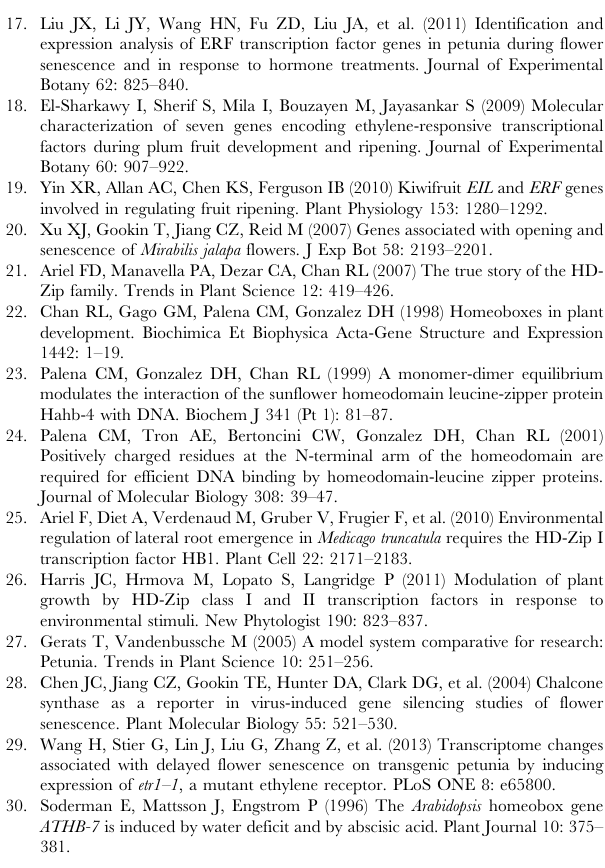
Figure S4 Silencing efficiency of VIGS determined by semi-quantitative PCR. Abundance of PhHD-Zip were deter- mined at D6 in purple control flowers (WT), in white flowers of plants inoculated with the CHS /TRV reporter construct (VW), and in purple flowers (PhHD-Zip(P)) and white flowers (PhHD- Zip(W)) of plants inoculated with the PhHD-Zip/CHS/TRV construct. A. A representative gel image from semi-quantitative PCR of RNA isolated from corollas. 26S RNA: the internal control. Samples were analyzed after 30 cycles PhHD-Zip and after 24 cycles for 26S RNA . B. Relative expression level of PhHD-Zip as determined by quantification of the gel pictures; error bars show SE of the means of three biological replicates; asterisks denote significant differences using Duncan’s test at P , 0.05). Figure S5 Phenotype of plants over-expressing PhHD- Zip . Representative fully-expanded young leaves of WT and 35S:: PhHD-Zip transgenic petunia lines ( # 2, # 3, # 6 and # 7). Representative flowers were harvested at anthesis.